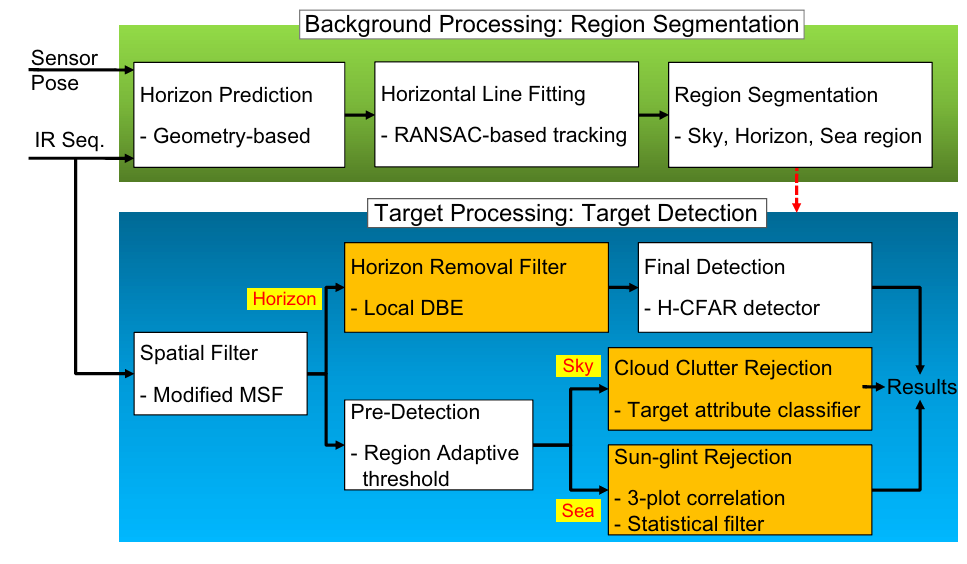
Figure 5. Overall small target detection flow based on region segmentation and region-specific clutter rejection.